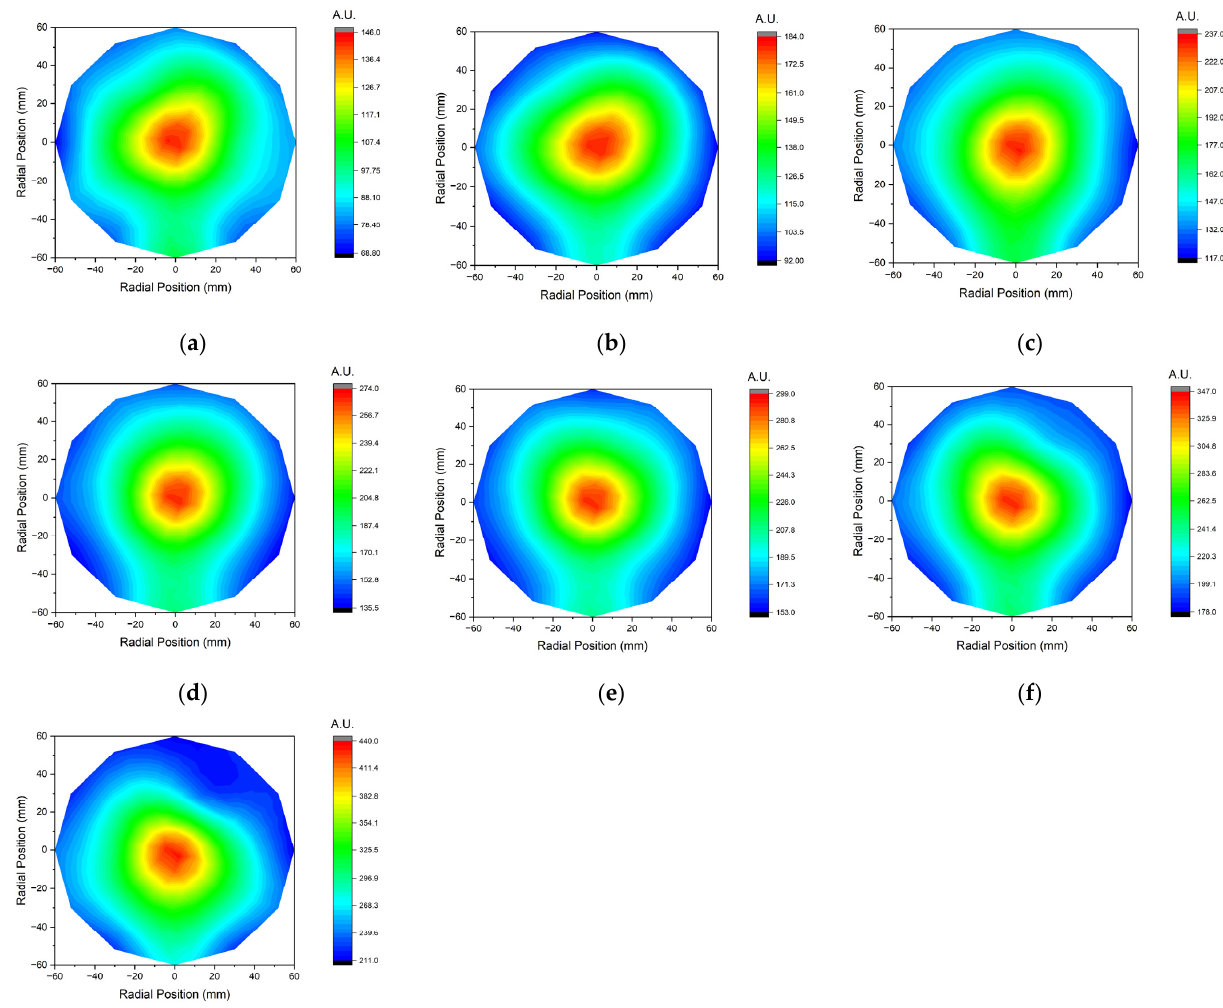
Figure 13. Contour map of ion current measured by IEMS according to RF power; ( a ) 100 W, ( b ) 150 W, ( c ) 200 W, ( d ) 250 W, ( e ) 300 W, ( f ) 350 W, and ( g ) 400 W. All data were acquired 30 s after plasma generation for stabilization.